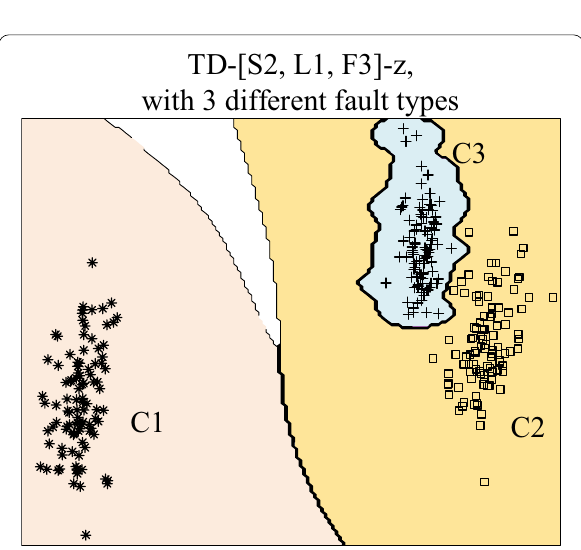
Figure 9 The original classification hyperplane of